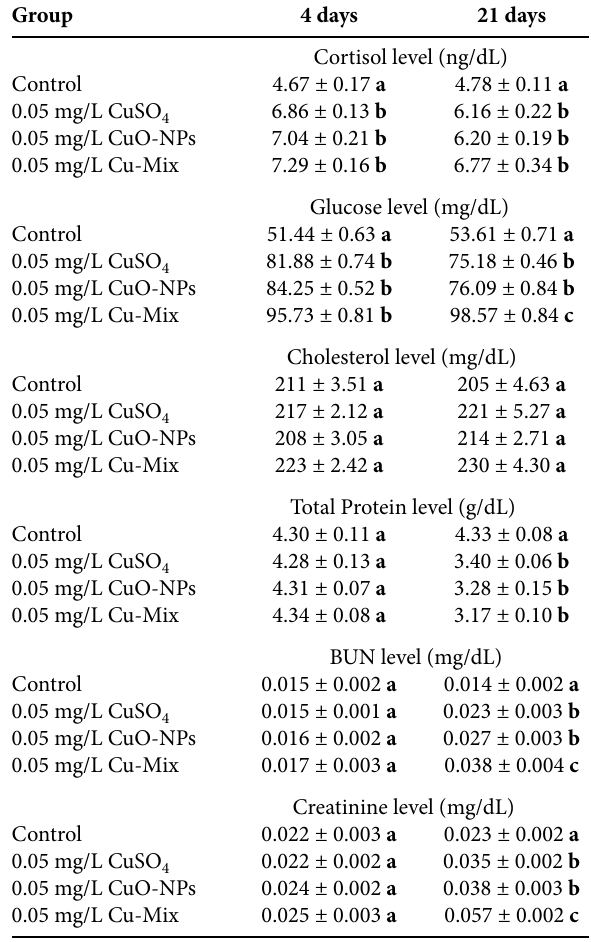
Table 2. Effects of individual and co-exposure of CuSO 4 and CuO-NPs on plasma metabolite level of O. niloticus